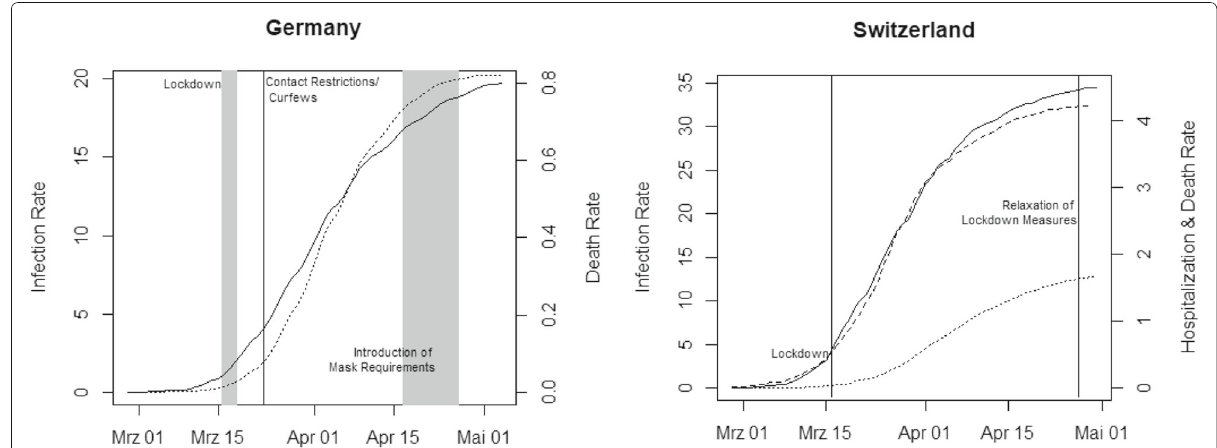
Fig. 1 Cumulative confirmed infections (solid line), deaths (dotted line), and hospitalizations (dashed line) per 10,000 inhabitants in Germany and Switzerland